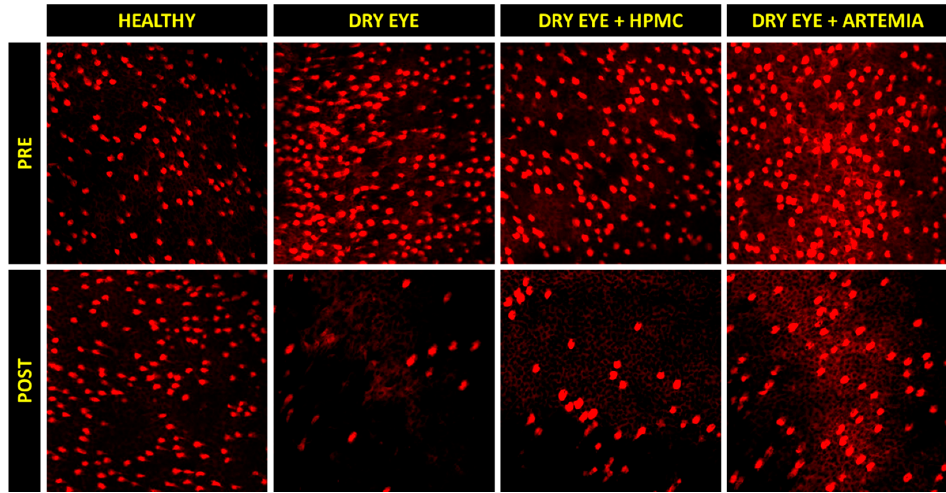
Figure 4. Representative images of the density of Goblet cells before (PRE) and after (POST) the instillation of the different treatments for 5 consecutive days. A decrease can be observed in the density of Goblet cells (brightest cells) in the three groups of rabbits with induced dry eye, but this decrease occurred in a lesser magnitude with the artificial tears based on Artemia salina .